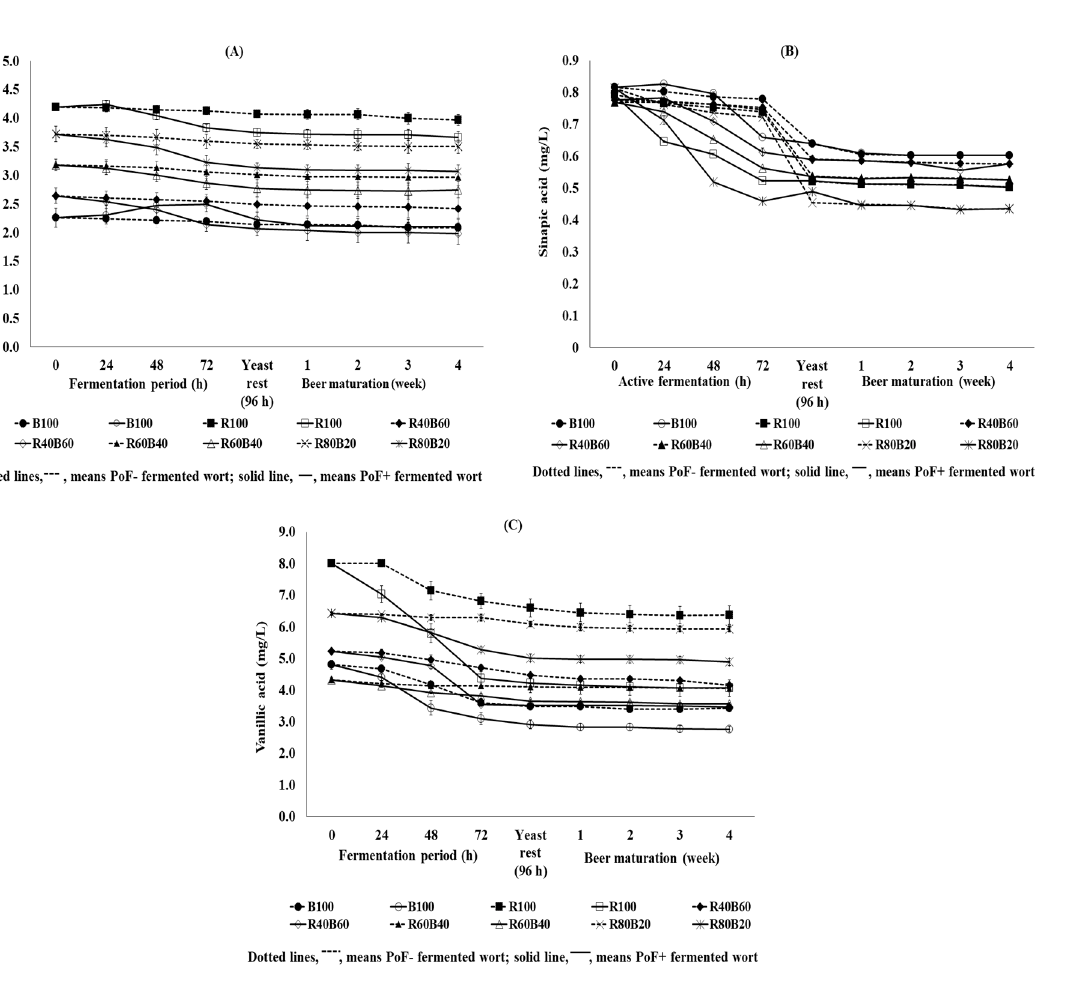
Figure 3. Changes in p -coumaric acid ( A ), sinapic acid ( B ), and vanillic acid ( C ) in fermented com- posite wort (B100, R40B60, R60B40, R80B20, and R100) by the two yeast strains BRY 97 ( S. cerevisiae ),